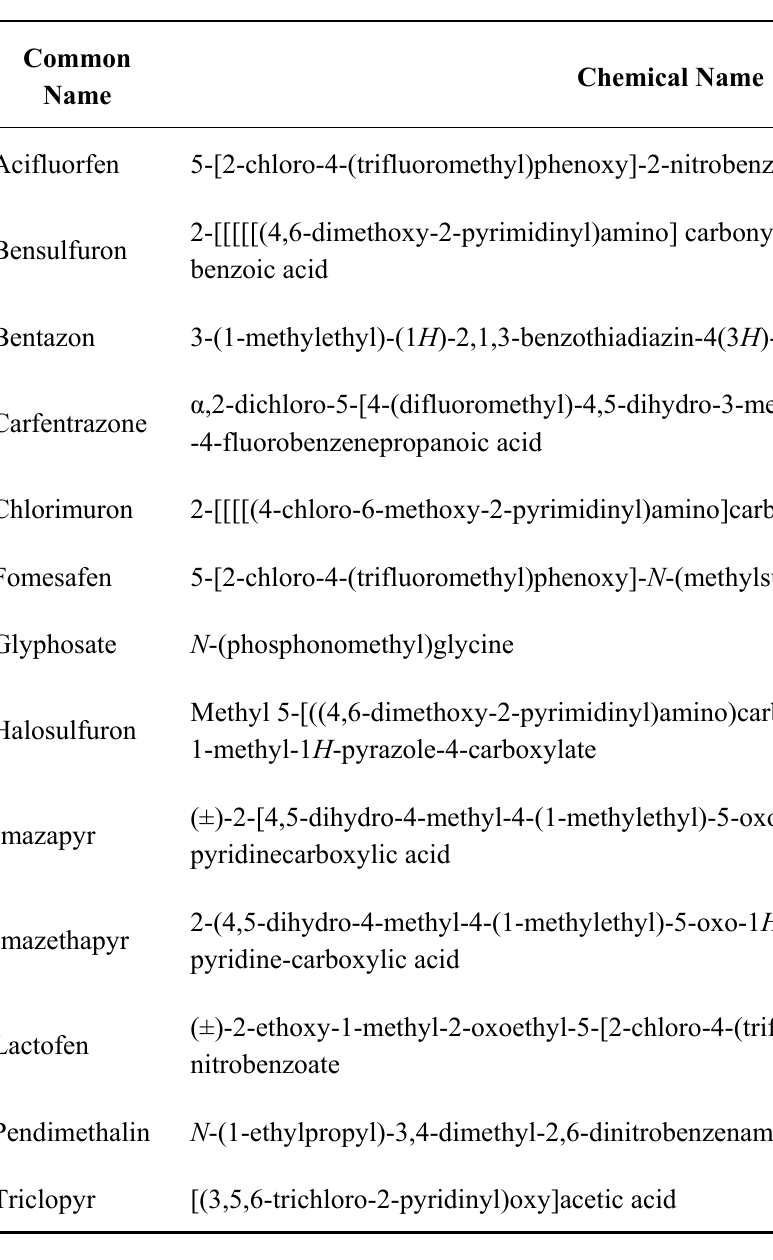
Table 1. Common and chemical names of herbicides mentioned in text